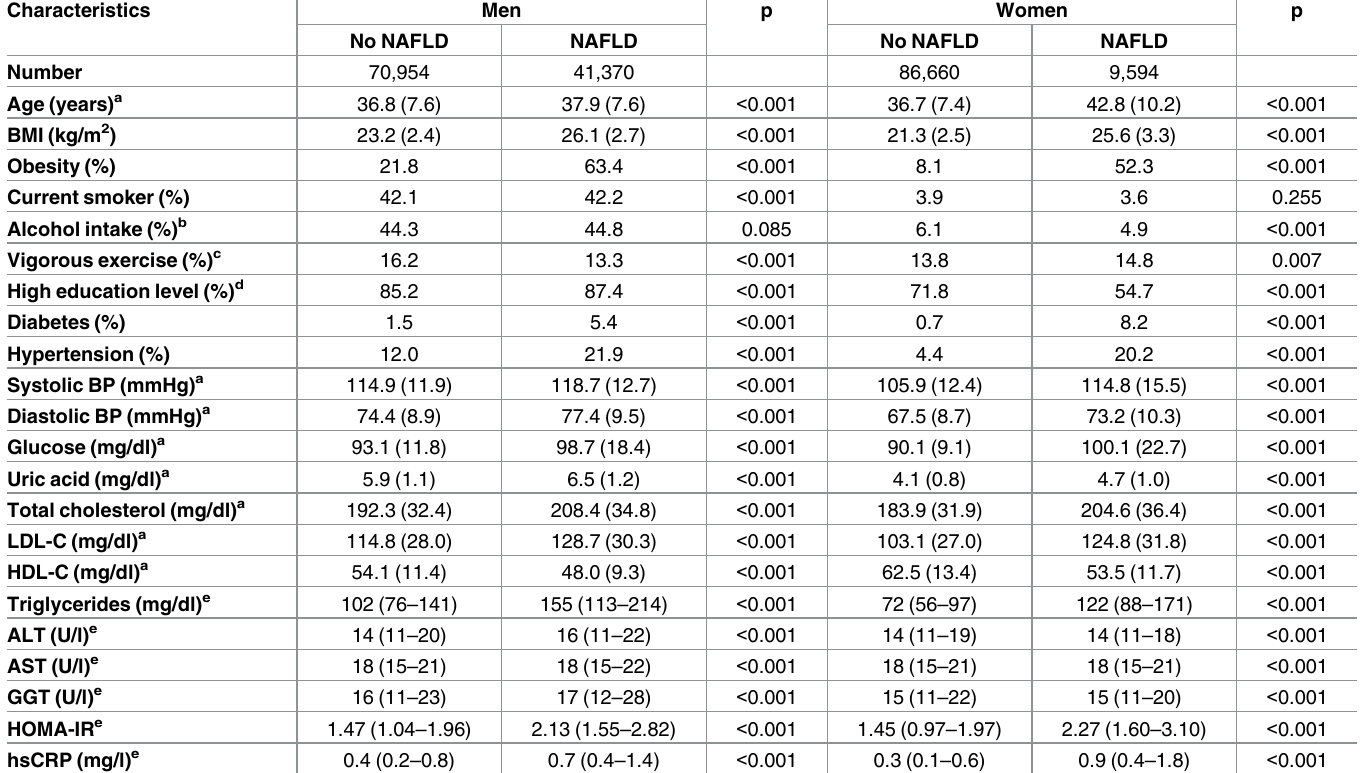
Table 1. Baseline characteristics of study participants by non-alcoholic fatty liver disease and